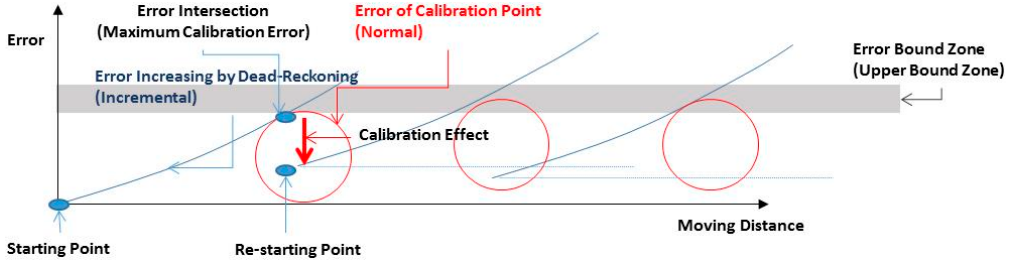
Figure 1. Calibration effect.